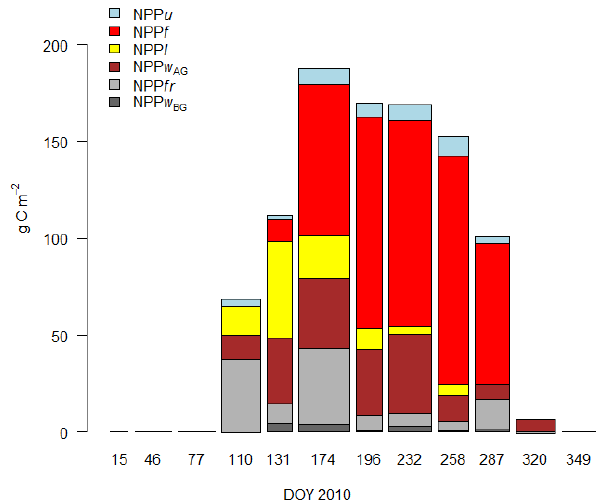
Fig. 5. NPP (gCm − 2 ) between each sampling date interval calcu- lated in the six considered ecosystem compartments. Bars’ width reflects the time (in days) that occurred between successive biomet- ric samplings.